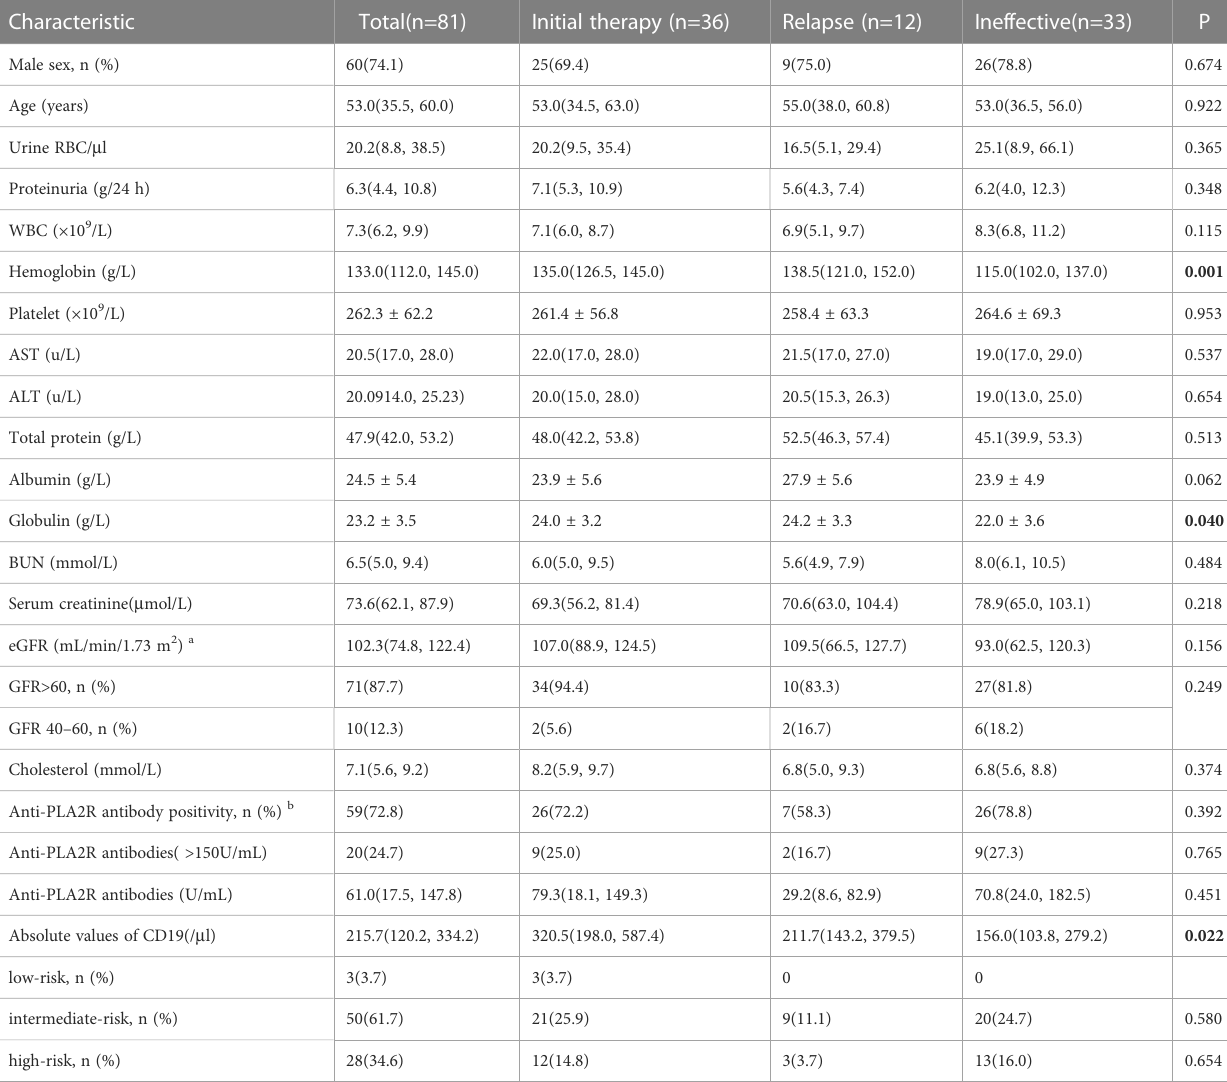
TABLE 1 Baseline characteristics of patients with PMN included in this study.